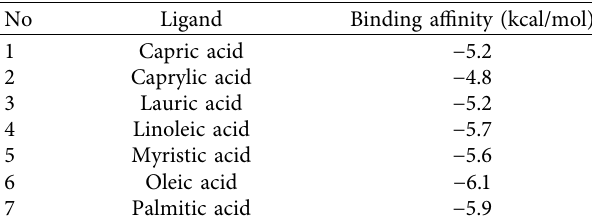
Table 2: Fatty acid binding affinity of PUO and EPUOE